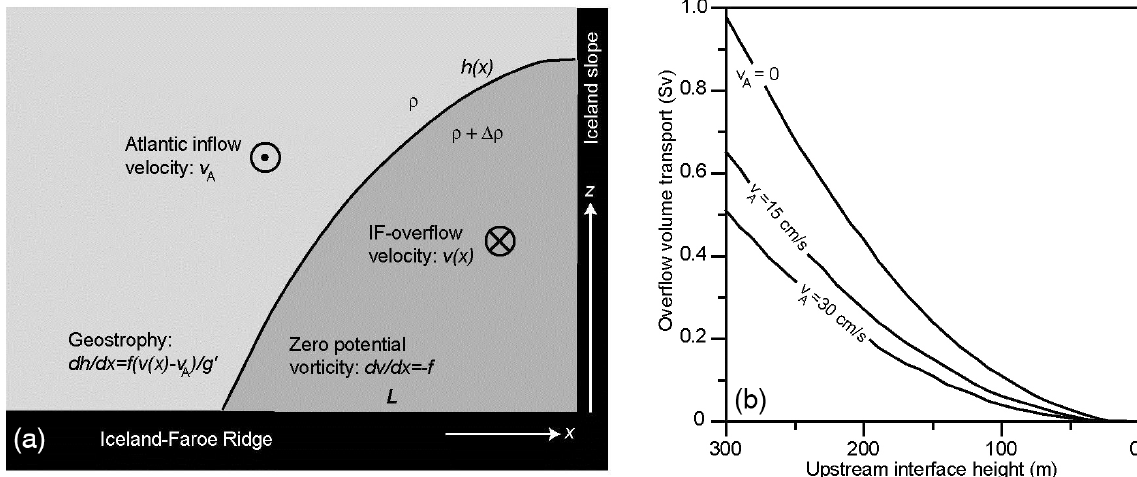
Figure 10. Two-layer model of the Western Valley assuming vertical Iceland slope and zero potential vorticity overflow below an Atlantic inflow of spatially constant velocity v A (a) . Overflow volume transport in the model assuming hydraulic control (maximum transport) as a function of upstream interface height h u for three different values of Atlantic inflow velocity v A (b) .